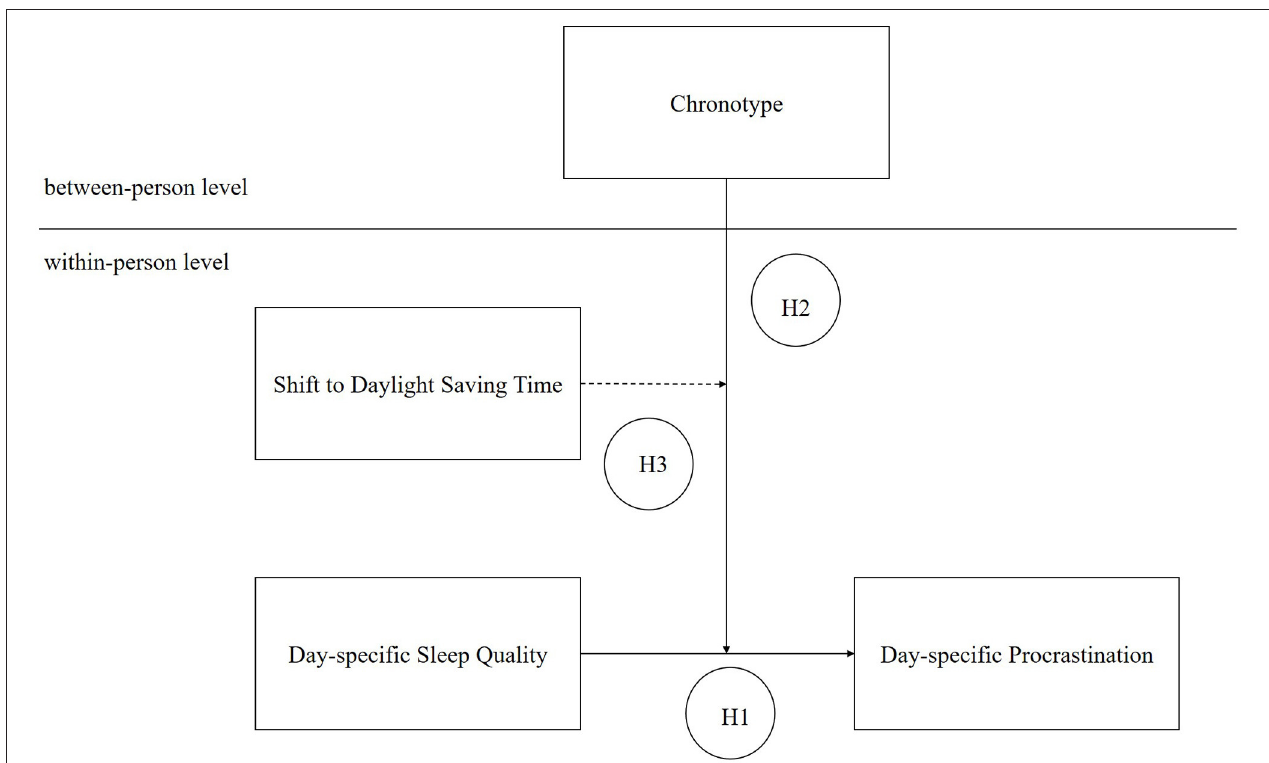
FIGURE 1 | Conceptual model of the current study. Within-person variance (Level-1 variance) captures the variation in variables from day to day within persons and between-person variance (Level-2 variance) captures the variation in variables between